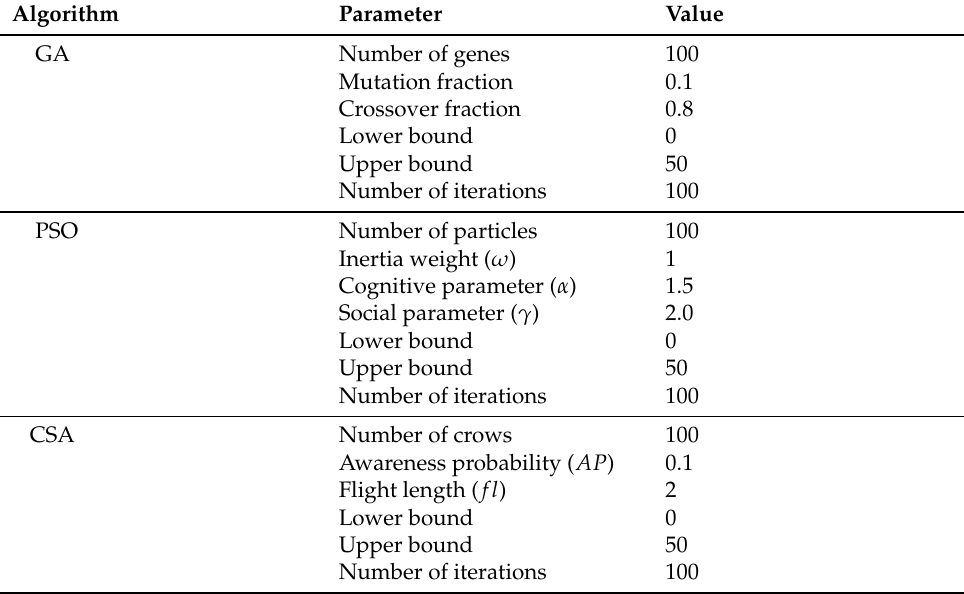
Table 1. Parameter setting of GA, PSO and CSA used in this study.